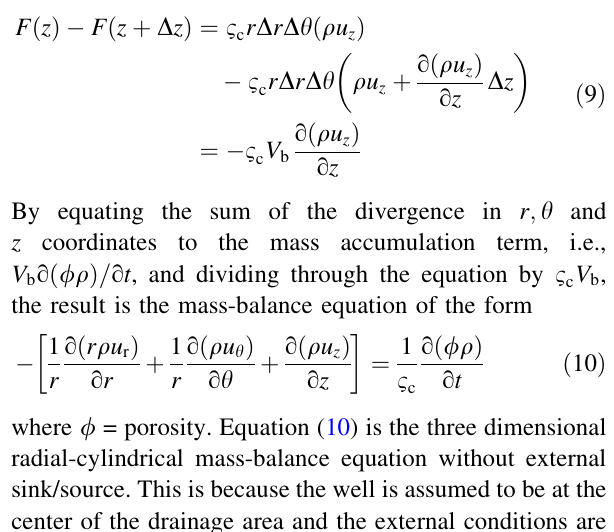
Fig. 1 Control volume in